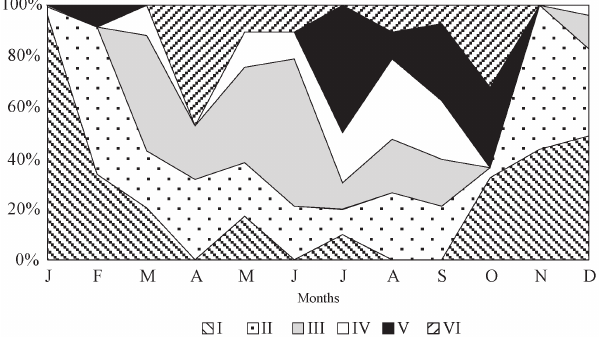
Fig. 5. Seasonal variation of development maturity ovary stages for Poecilia sphenops